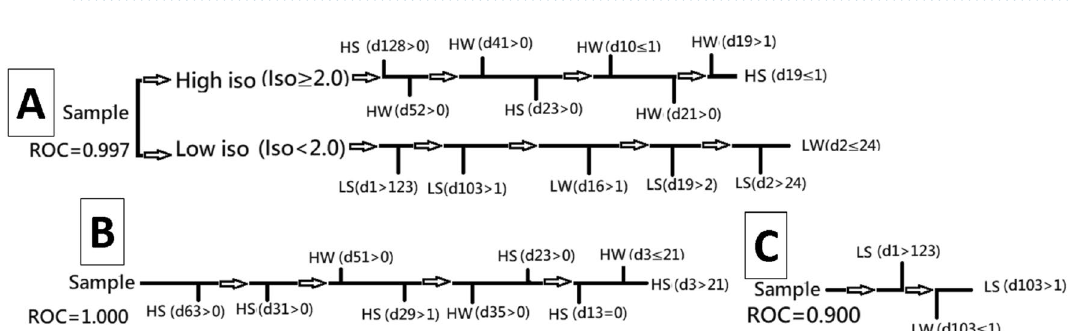
Figure 2. Plot ( A ) is a flow chart that includes encoding fMRI to power law and using decision tree to classify states. Plot ( B ) shows the transition between two states. If a situation has several paths, decision tree can help us detect which is the right way during evolution.